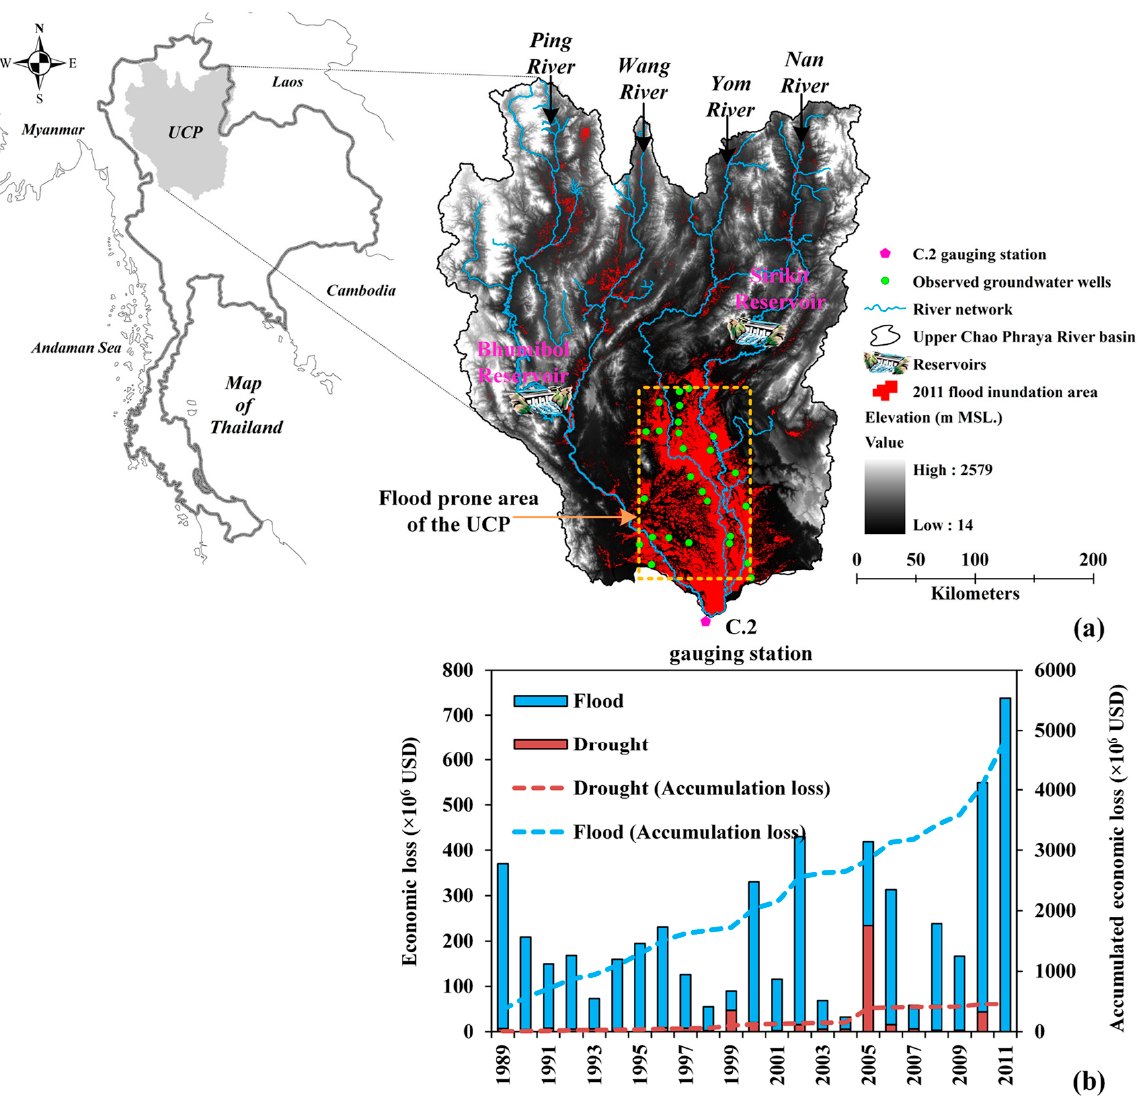
Figure 1. Study area. ( a ) Upper Chao Phraya River basin and ( b ) flood and drought damage in Thailand.